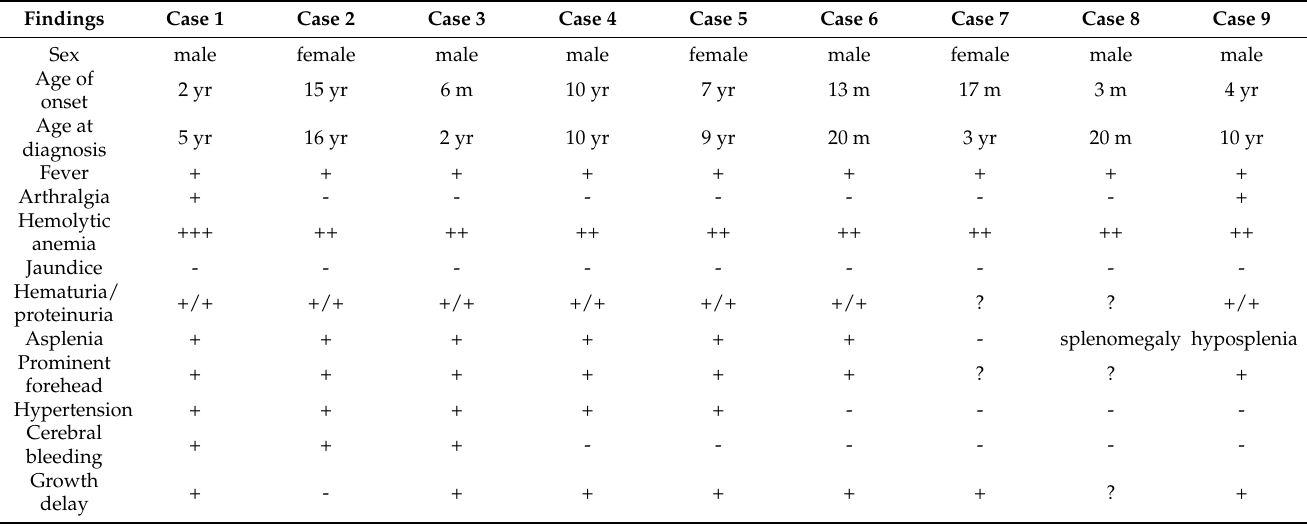
Table 1. Clinical profiles of human HO-1 deficiency with null mutations of HMOX1.